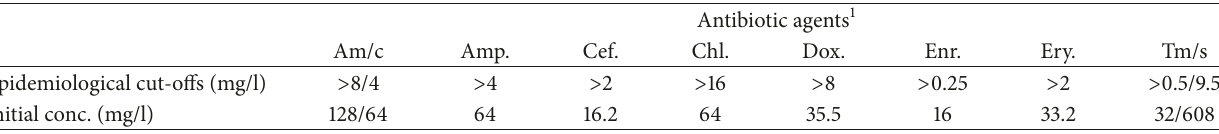
Table 1: Epidemiological cut-offs (mg/l) for the eight antibiotics tested and the initial working concentrations (mg/l) of the eight antibiotics used in the MIC